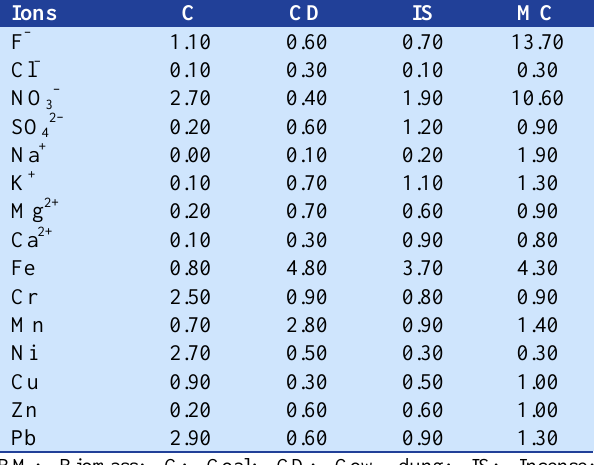
Table 3. Enrichment of ions and metals in the indoor ash residues with respect to the BM ash content